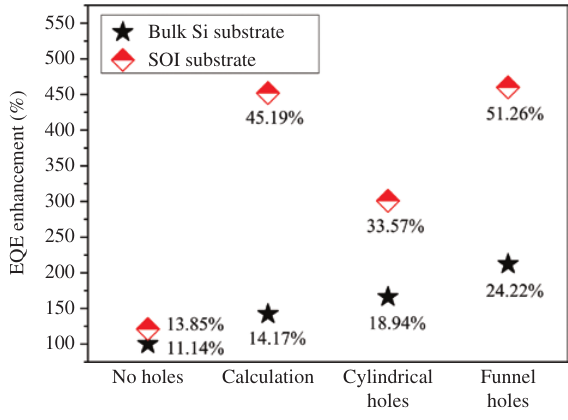
Figure 6: The EQE enhancement (relative to a device without holes on bulk Si substrates) of photodiodes with light-trapping holes on SOI substrates at the wavelength of 850